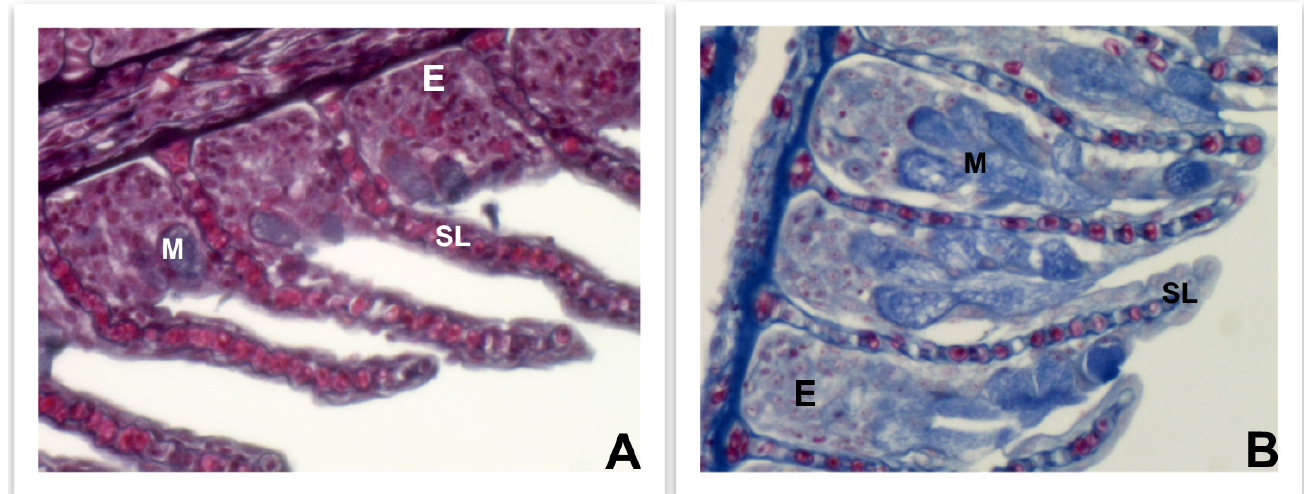
Figure 3. Light micrographs of the gills of Anguilla anguilla . Mallory staining. ( A ) Control and ( B ) exposed specimens. In exposed specimens, the epithelium (E) appeared thickened, compared to control, and contained many mucous (M) cells, also present in the secondary lamellae (SL), which appeared partially fused. Magnification: 400×.